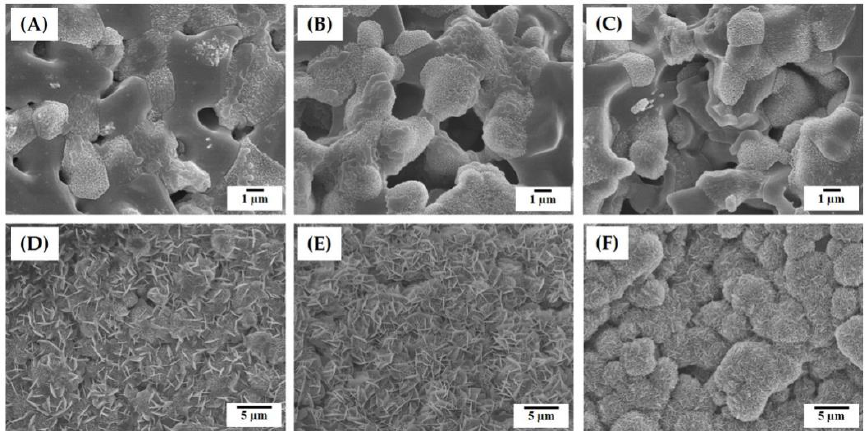
Figure 12. Representative FE-SEM images showing the surface morphologies of the microporous CaP frameworks obtained using a range of camphene-camphor amounts (( A , D ) 40 vol %, ( B , E ) 50 vol %, and ( C , F ) 60 vol %) after immersion in the SBF solution for ( A – C ) 6 h and ( D – F ) 24 h.